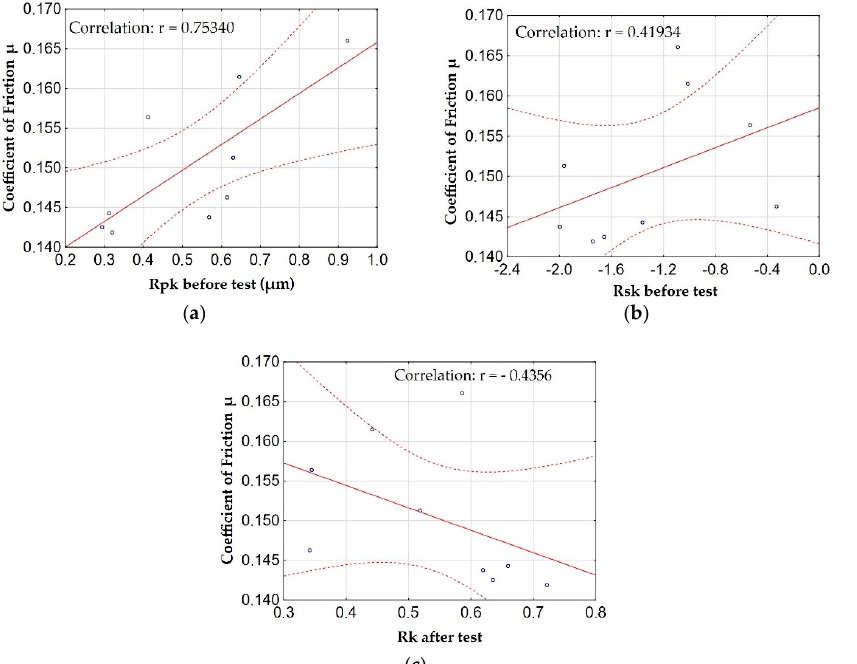
Figure 12. Relationships between the coefficient of friction µ and: ( a ) the Rpk parameter before the test, ( b ) the Rsk parameter before the test, ( c ) the Rk parameter after the test. The analysis of the correlation of the friction coefficient µ showed that the Rpk pa- rameter before the tribological test shows a high correlation (significant relationship) with the friction coefficient µ. On the other hand, the parameters Rsk before the tribological test and the parameter Rk after the tribological test show a moderate correlation (signifi- cant relationship) with the friction coefficient µ. The Rpk and Rsk parameters before the tribological test are characterized by a positive correlation, in other words, the change in the friction coefficient µ is proportional to the change in parameters. The values of the Rk parameter after the tribological test are inversely proportional to the friction coefficient µ. Figure 13 shows the roughness profile for the aluminum alloy EN AW-5251 and the Al 2 O 3 layer (sample F).